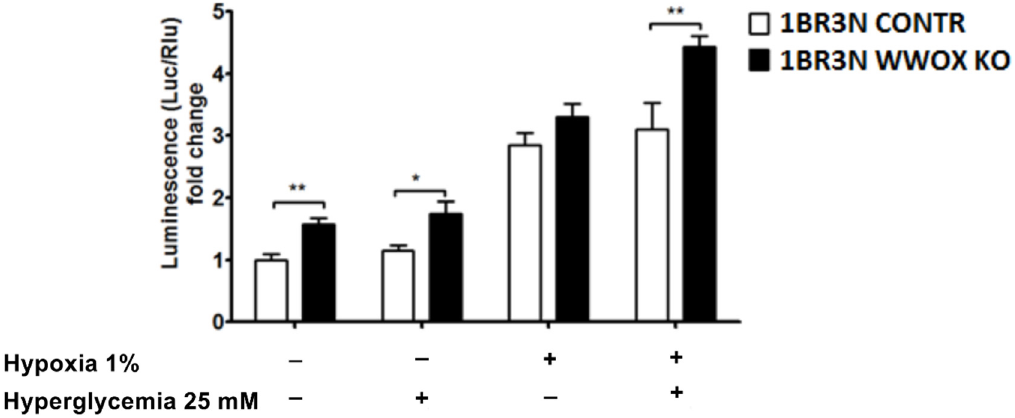
Figure 2. Obtained variants of 1BR.3.N cell line (1BR.3.N CONTR and 1BR.3.N WWOX KO) was transfected with a luciferase reporter gene under the regulation of Hypoxia-Responsive Elements (HRE) and subjected to all tested conditions for 6 h. Extracts were analyzed for luciferase activity. The values are mean ± SEM. *, p < 0.05; **, p < 0.01.